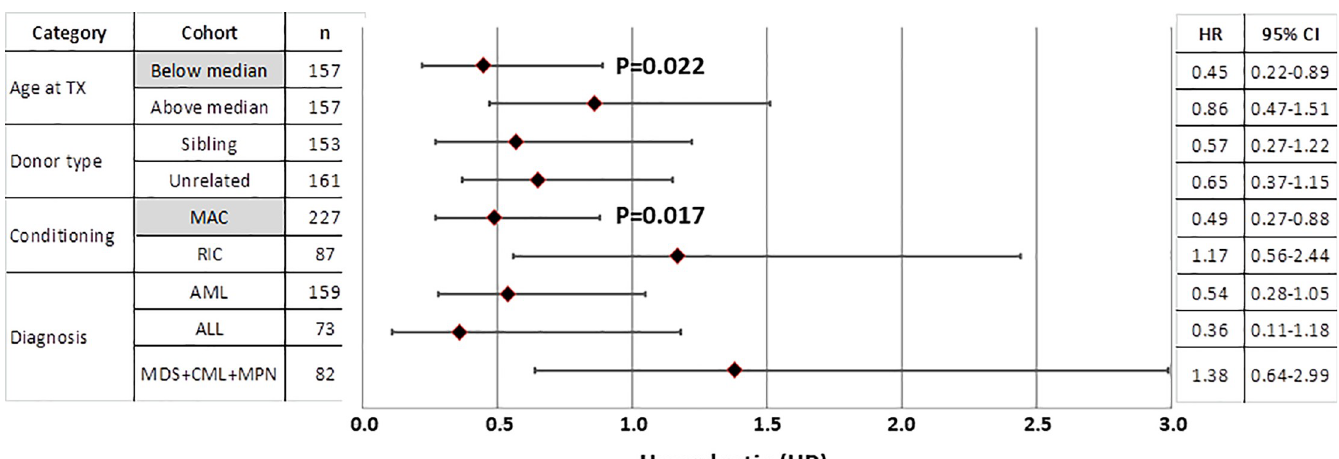
PLOS ONE | https://doi.org/10.1371/journal.pone.0218945 June 25,